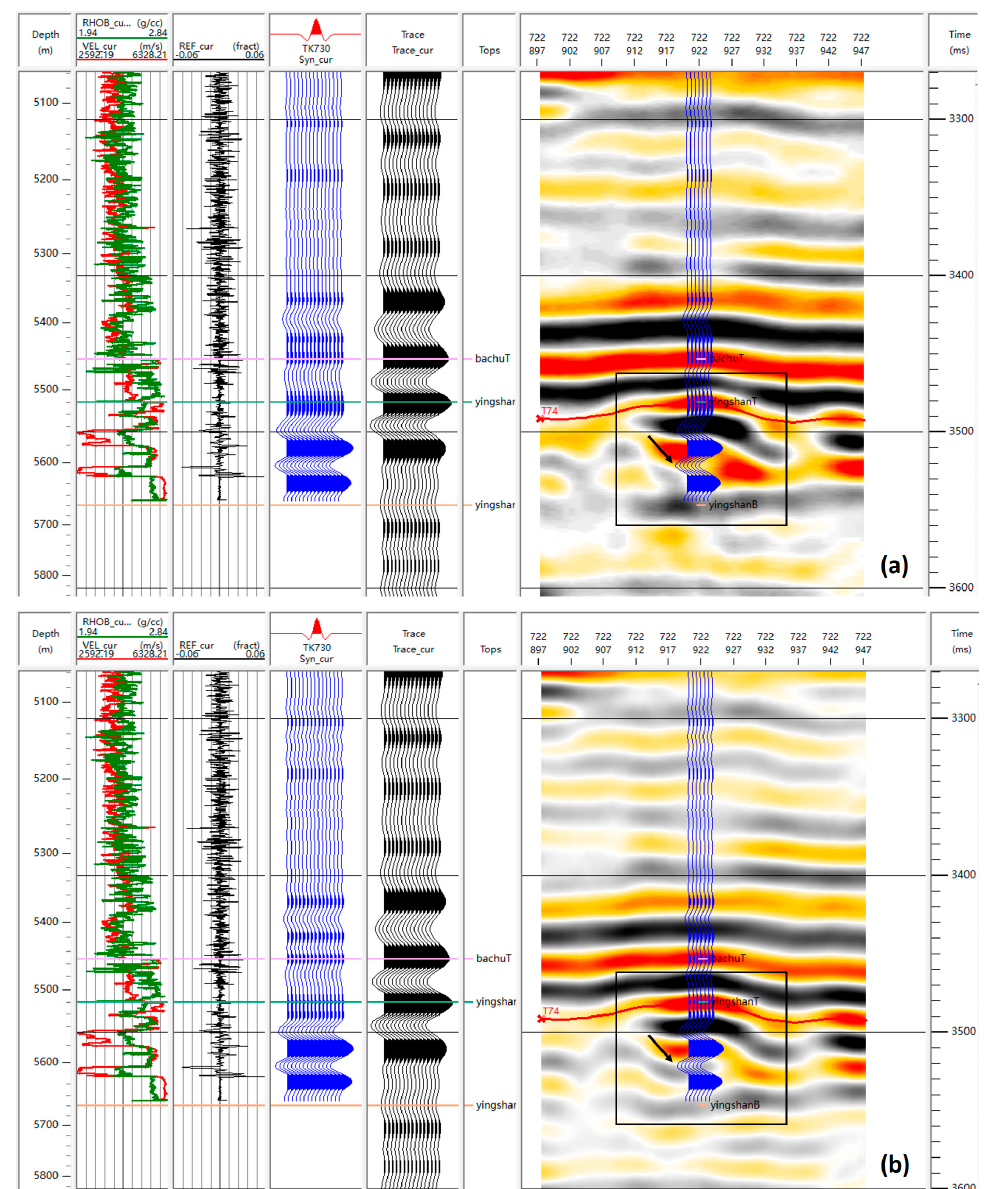
Figure 6. A comparison of synthetic traces (blue) with ( a ) the full-band and ( b ) a selected 35-Hz frequency profile.